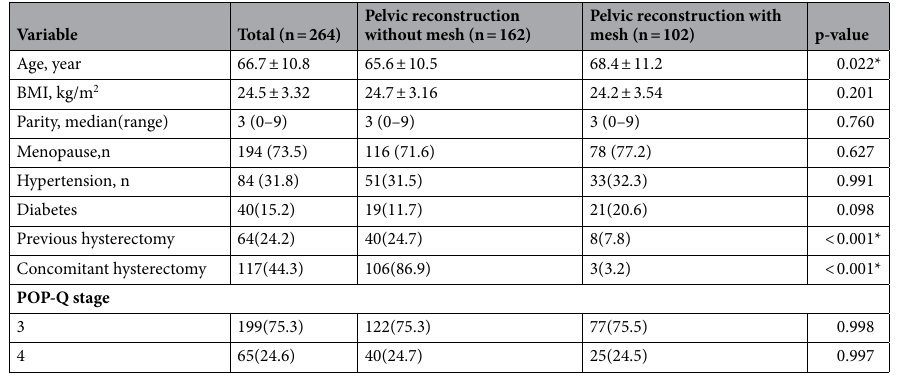
Table 1. Baseline characteristics of patients for the two surgical approaches by individual surgeon. Data are presented as the mean ± standard deviation, median with range, or number (%); Pearson’s chi-squared test, independent sample t-test, and Mann–Whitney test were used for categorical data, mean values, and median values, respectively, unless otherwise specified. BMI body mass index, POP-Q pelvic organ prolapse quantification. *Indicates significant p value <